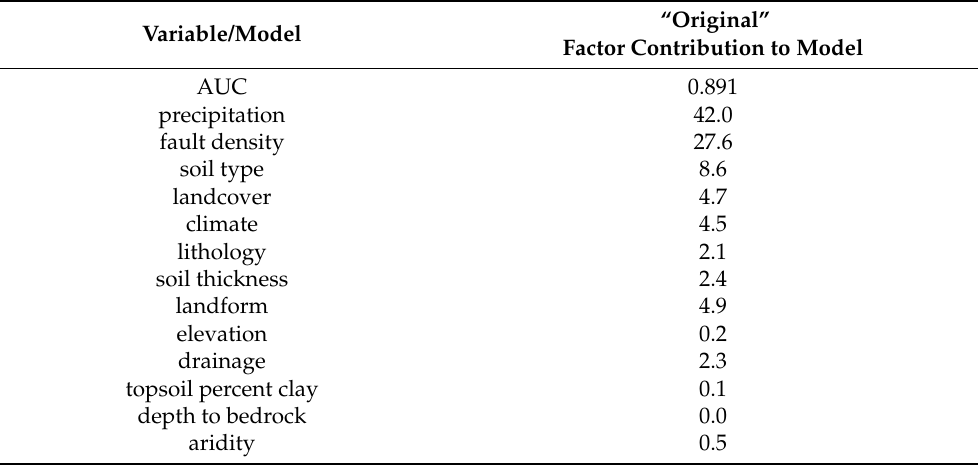
Table 3. AUC and factor contribution derived from MaxEnt “Original” model.